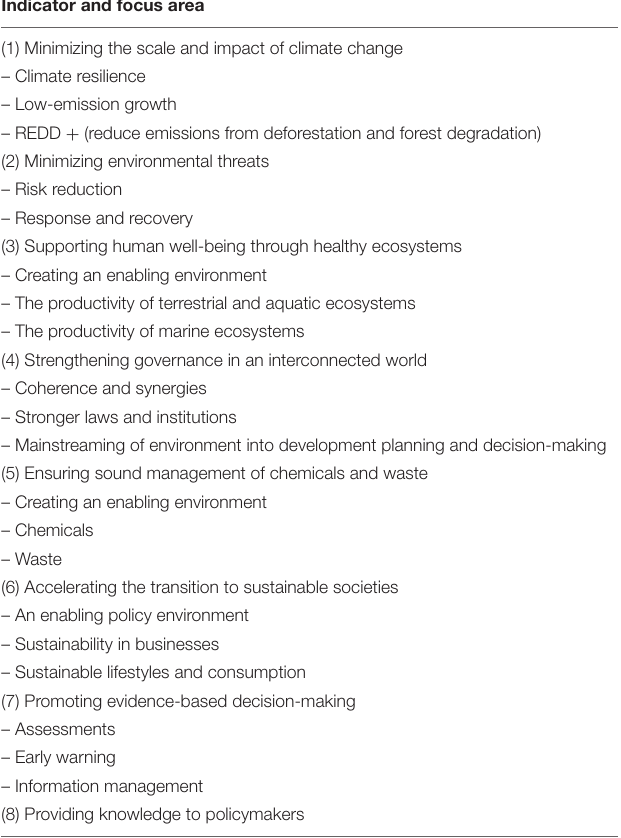
TABLE 2 | UNEP climate mitigation